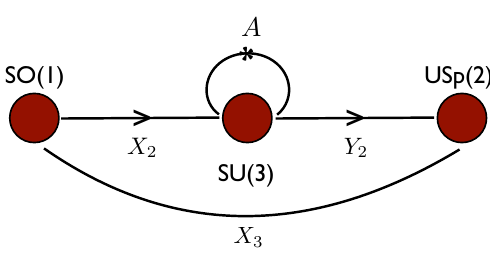
Figure 4 . The quiver of the 3{2 model at the C 3 = Z orbifold singularity. Matter (cid:12)elds follow 6 0 the de(cid:12)nitions in eq. (3.5). Arrows are indicated only when needed (for USp(2) = SU(2) the fundamental and anti-fundamental are equivalent representations). The asterisk refers to the anti- symmetric representation, as in (cid:12)gure